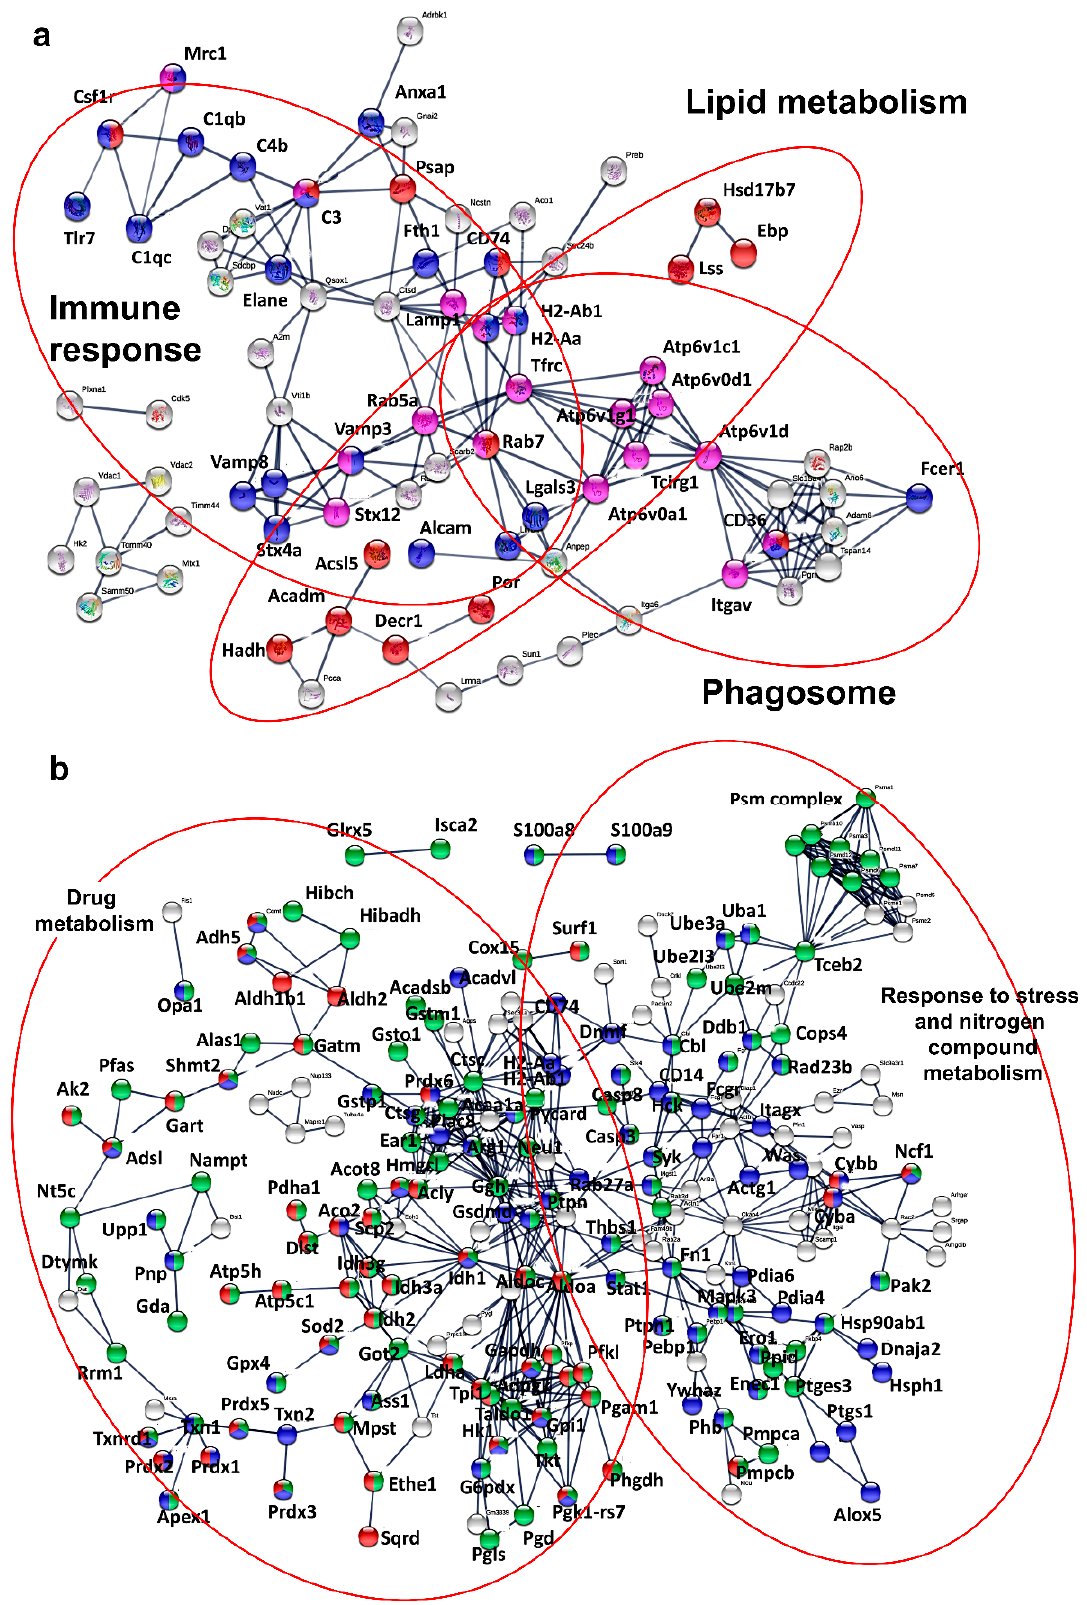
Figure 3. Cancer-specific interactomes in ex vivo-differentiated myeloid subsets. ( a ) TAM-specific upregulated functional interactomes compared to M0 macrophages reconstructed with STRING. The color codes represent protein nodes belonging to the indicated pathways. ( b ) Same as in ( a ), but with MDSC-specific upregulated functional interactomes.